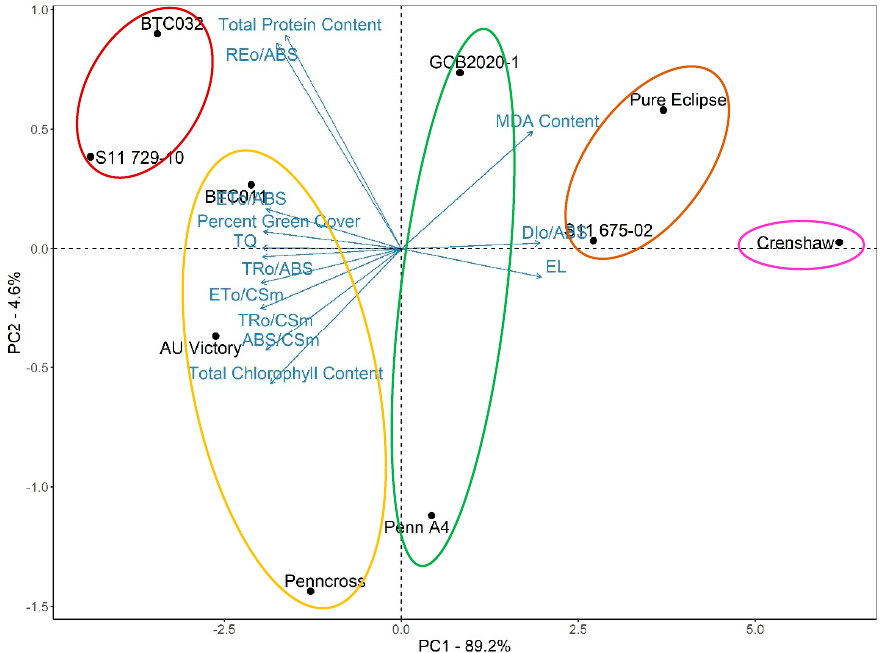
Figure 14. Principal component analysis for different parameters of creeping bentgrass at 35 d under heat stress (38/33 °C day/night) condition. Principal component 1 is represented on the X axis while principal component 2 is represented on the Y axis. Vectors indicate the direction and contribution of each parameter to the overall distribution of various lines. Circles of different colors indicate different clusters.